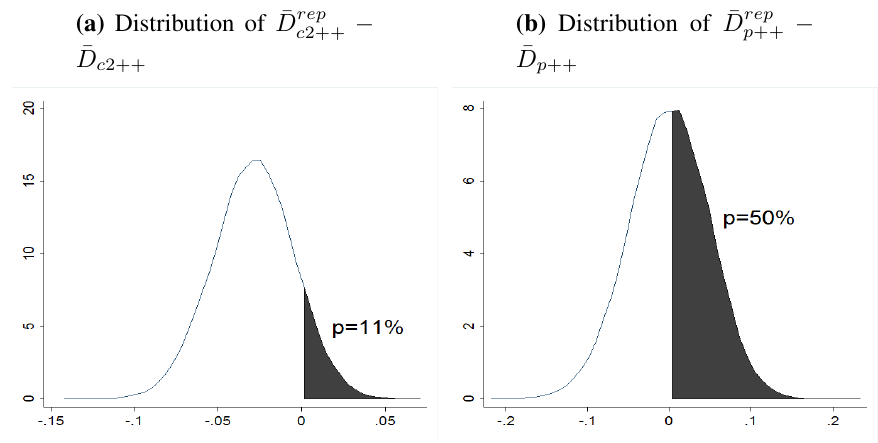
Figure 4. Posterior predictive checking: Distributions of ¯ D rep as well as corresponding discrepancy